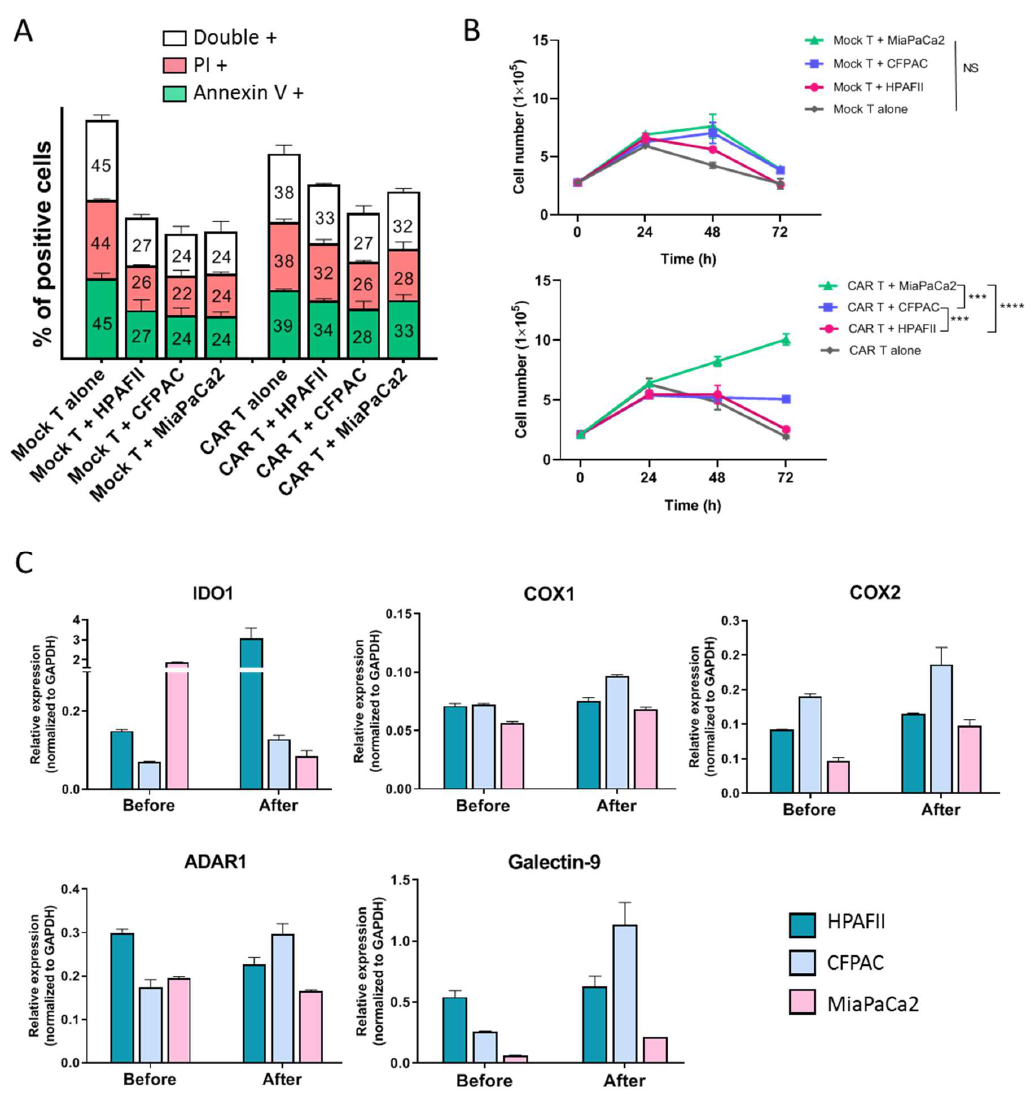
Figure 5. Deciphering the resistance mechanism utilized by PDA cells against CAR T cell therapy. ( A ) Apoptosis of CAR T cells before and after exposure to HPAFII, CFPAC, and MiaPaCa2 cells. Mock and CAR T cells were co-cultured with PDA cells and their apoptosis level was measured by Annexin V/PI staining at 24, 48, and 72 h post co-culture. ( A ) shows the average percentage of positive Annexin V, PI, or both in T cells after 48 h co-culture. Statistical analysis with one-way ANOVA comparing the mean of three groups (CAR T + HPAFII vs. CFPAC and vs. MiaPaCa2) showed no difference between apoptosis levels of CAR T cells. ( B ) Mock and CAR T cells proliferation over time after exposure to HPAFII, CFPAC, and MiaPaCa2 cells. T cells were enumerated using an automated cell counter. MiaPaCa2 cells enhanced proliferation of CAR T cells after 48 and 72 h, whereas CFPAC and HPAFII cells hindered CAR T cells proliferation. Mock T cells did not show the same trend. Significance of data was evaluated using two-way ANOVA (Multiple Comparison). Error bars, SEM. *** p < 0.001, **** p < 0.0001. ( C ) q-PCR data showing relative expression level of five important genes in HPAFII, CFPAC, and MiaPaCa2 cells before and after exposure to CAR T cells. CTs are normalized to GAPDH in each sample and a higher number in Y -axis represents higher expression of the gene. IDOI, COX1 / 2, ADAR1, and galectin-9 genes were overexpressed in resistant PDA cells after exposure to CAR T cells. For more details, see Figure S3. Error bars, SEM. n = 3.